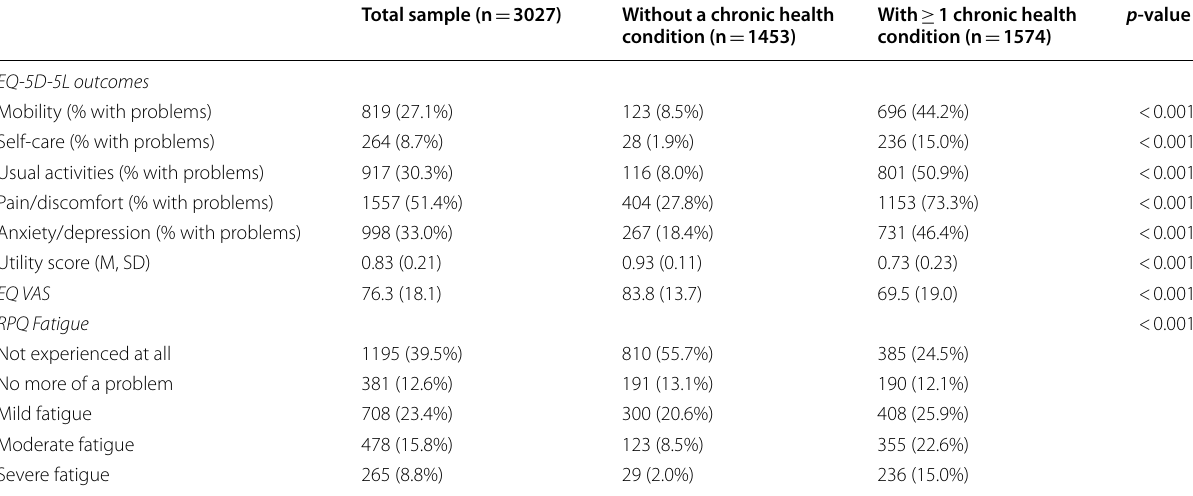
Table 2 EQ-5D-5L and fatigue